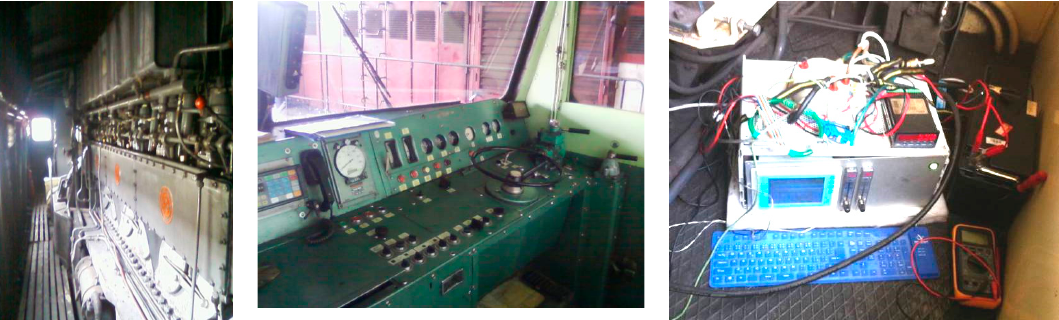
Figure 3. ˇCKD Series 749 diesel-electric locomotive: ˇCKD K 6 S 310 DR engine ( left ); locomotive Figure 3. Č KD Series 749 diesel-electric locomotive: Č KD K 6 S 310 DR engine ( left ); locomotive controls ( middle ); and portable emissions monitoring system ( right controls ( middle ); and portable emissions monitoring system ( right ).